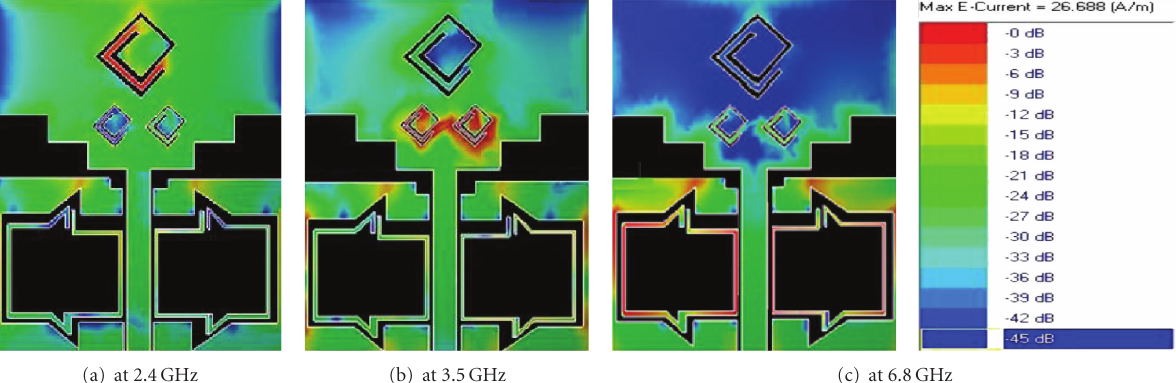
Figure 7: Current distribution of the proposed antenna.